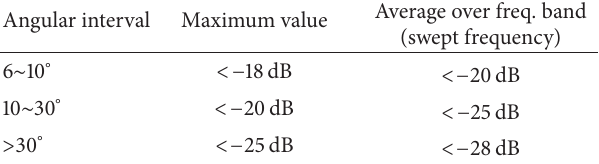
Angular interval Maximum value Average over freq. band